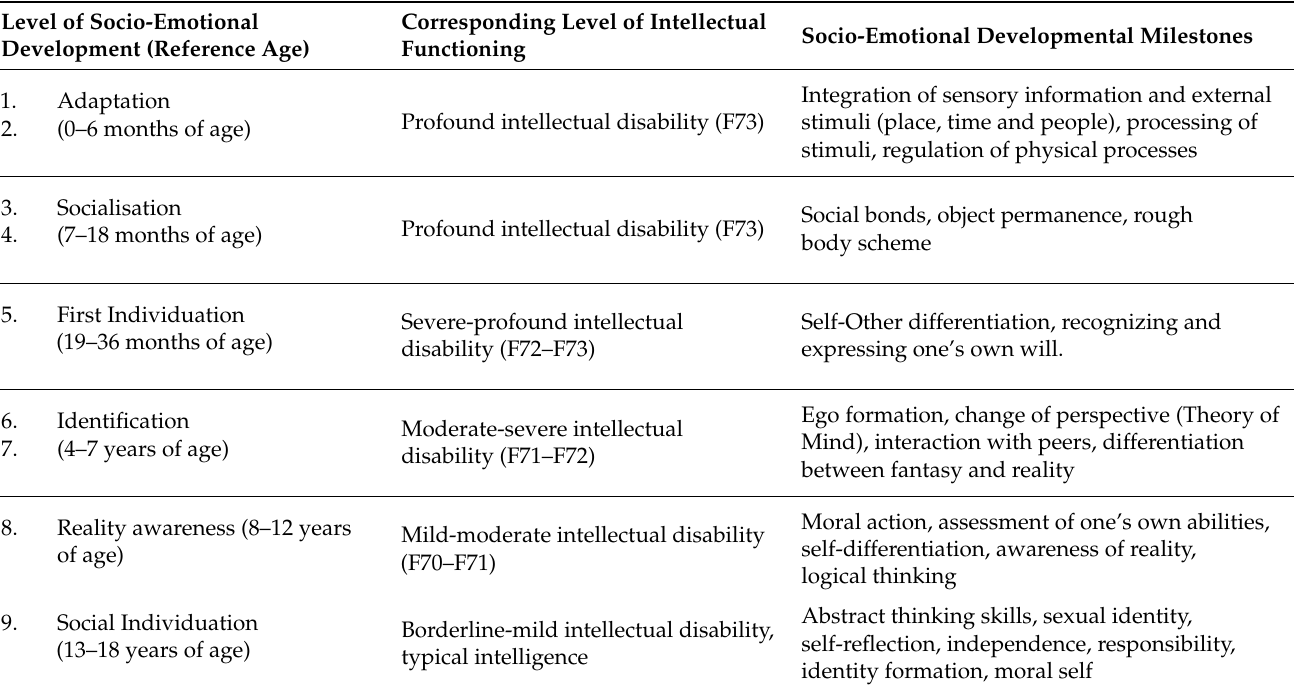
Table 1. Development of socio-emotional brain functions